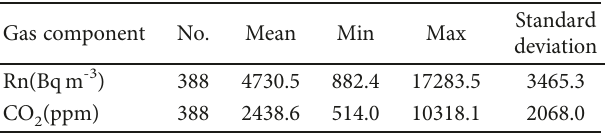
concentrations and Rn activities in soil sampling